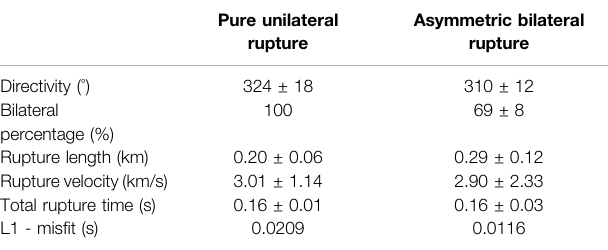
TABLE 2 | Inversion of apparent durations for the Mw 4 Montesano earthquake using a trust-region algorithm considering a pure unilateral rupture model and an asymmetric bilateral rupture